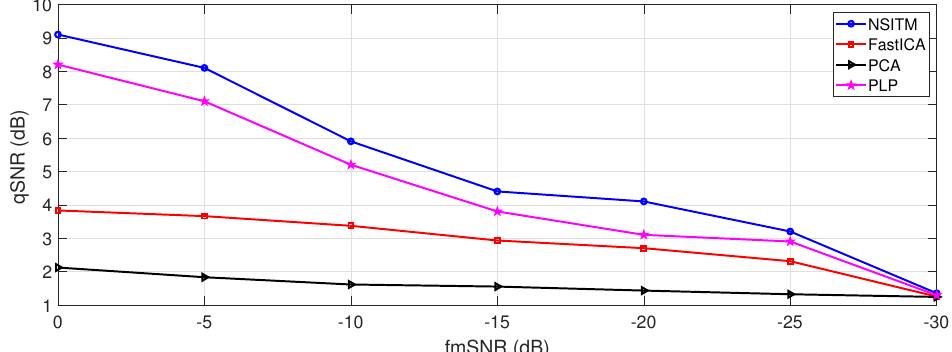
Figure 18. Comparison between qSNR of the proposed NSITM, FastICA, PCA, and PLP algorithms, in terms of fmSNR variations, using Physionet/Fetal ECG Synthetic database (FECGSYNDB). The selected event is maternal heart rate (MHR)/FHR acceleration/deceleration plus noise. The term qSNR is computed by